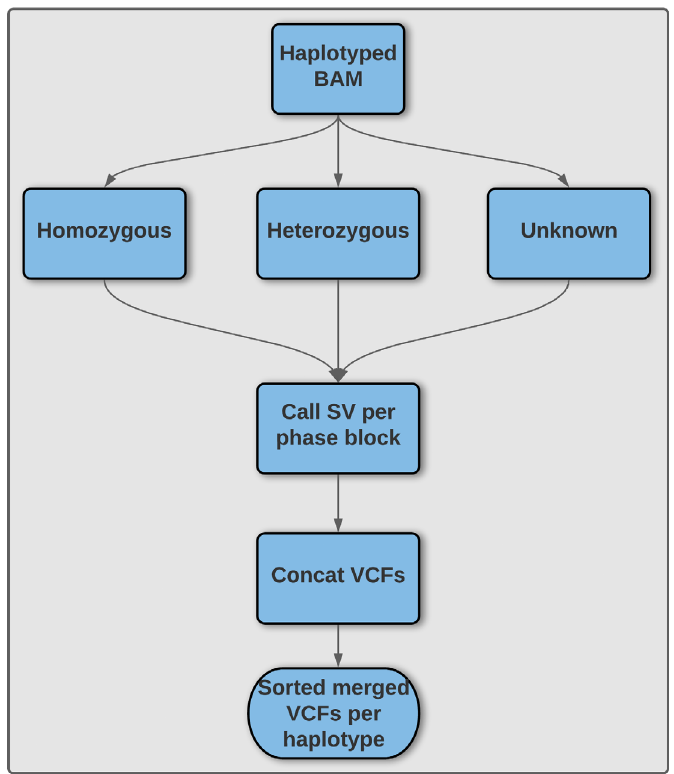
Figure 5. Illustration of methodology utilized by Sniphles to produce a phased structural variant call set. An overview of the Sniphles pipeline demonstrating how a haplotyped input bam file is used to generate a phased structural variant call